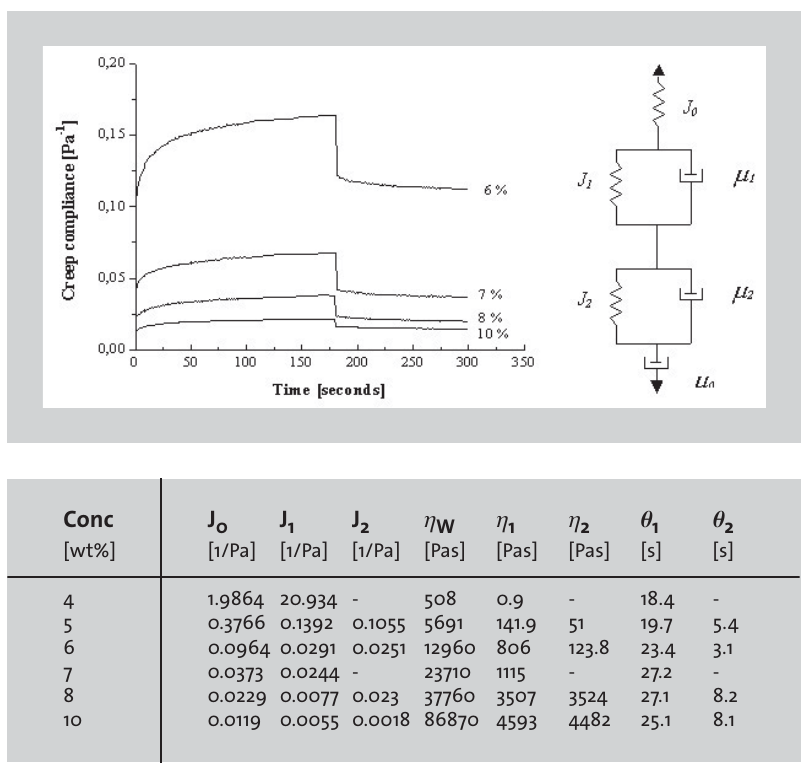
Figure 3 (above): Creep compliance and recovery curves for different concen- trations (6, 7, 8 and 10 wt%). A mechanical model which may be used to describe the creep results is also shown (a Maxwell unit in series with two Kelvin-Voigt units). Note that creep curves for 4 and 5 wt% concentrations are not represented here (Jmax= 0.65 Pa -1 at t = 180 s for 5 wt%). Table 1 (below): Viscoelastic parameters of the different